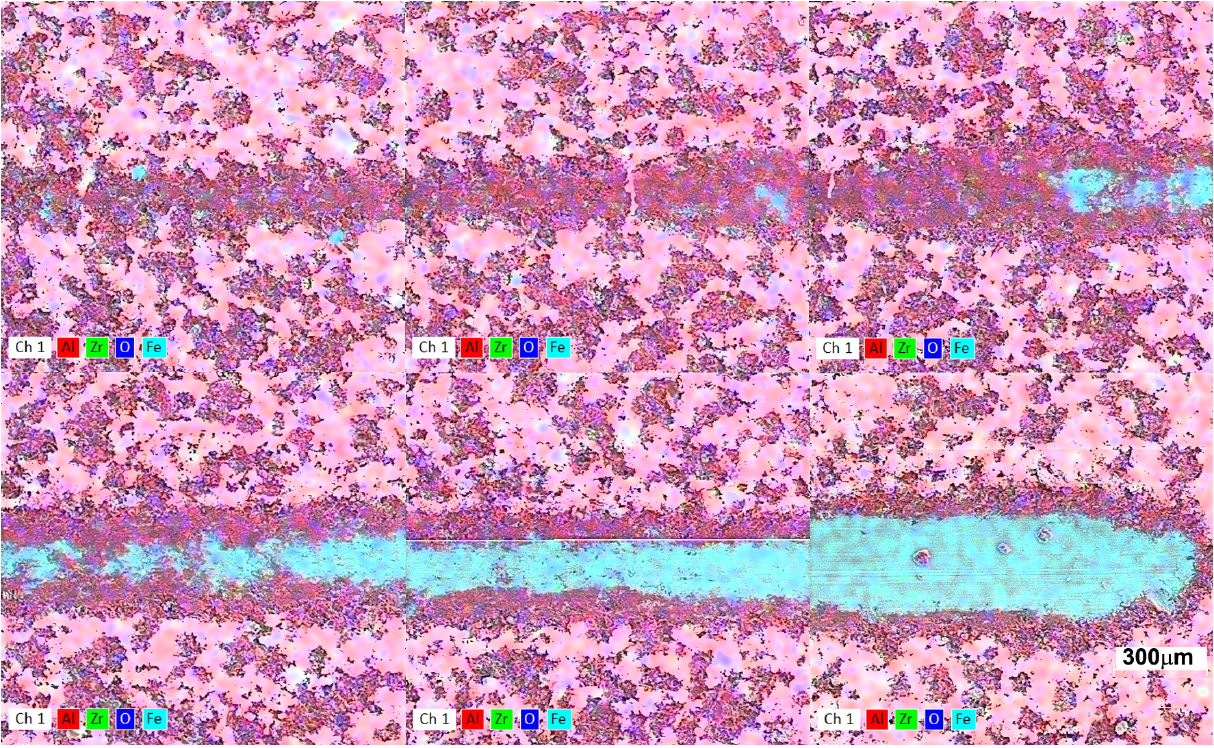
Figure 9. Elemental distribution on the scratched area of the ceramic layer.